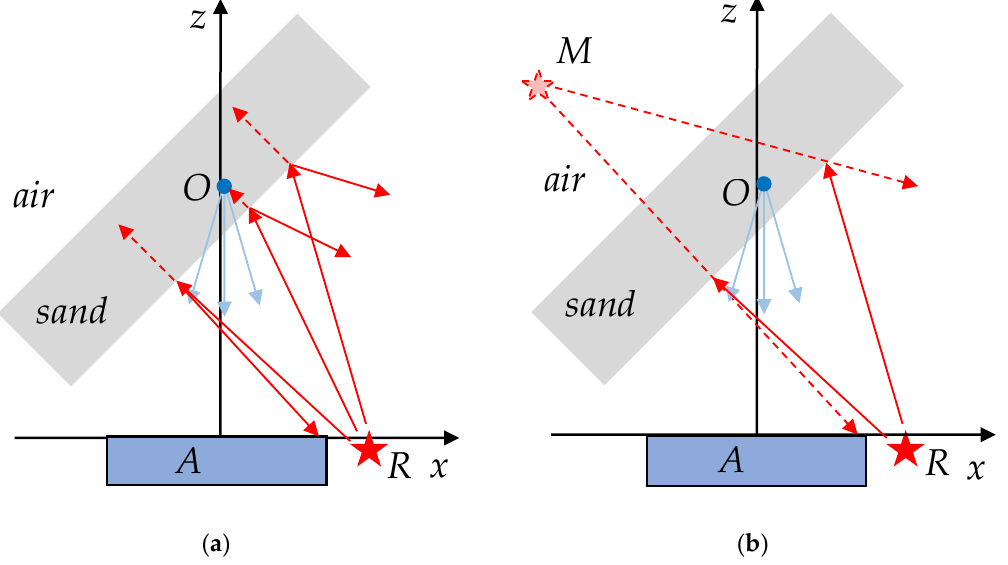
Figure 17. Geometry of oblique probing ( a ); imaginary source does not irradiate HSR aperture ( b ). Notations: radiator, R; object, O; holographic antenna, A; mirror source image, M. Arrows mark the incident and reflected waves/